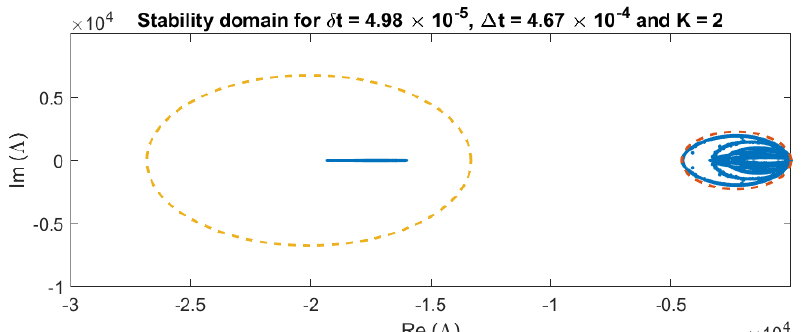
Figure 10. Stability domain of PFE method (yellow dashed for inner integrator, red dashed for outer integrator) for δ t = 4.98 × 10 − 5 , ∆ t = 4.67 × 10 − 4 and K = 2 together with numerical eigenvalue spectrum (blue dots) for slip length λ = 10 − 4 , friction coefficient ν = 0.1, spatial resolution n x = 1000 and N = 3 moments for dam break test